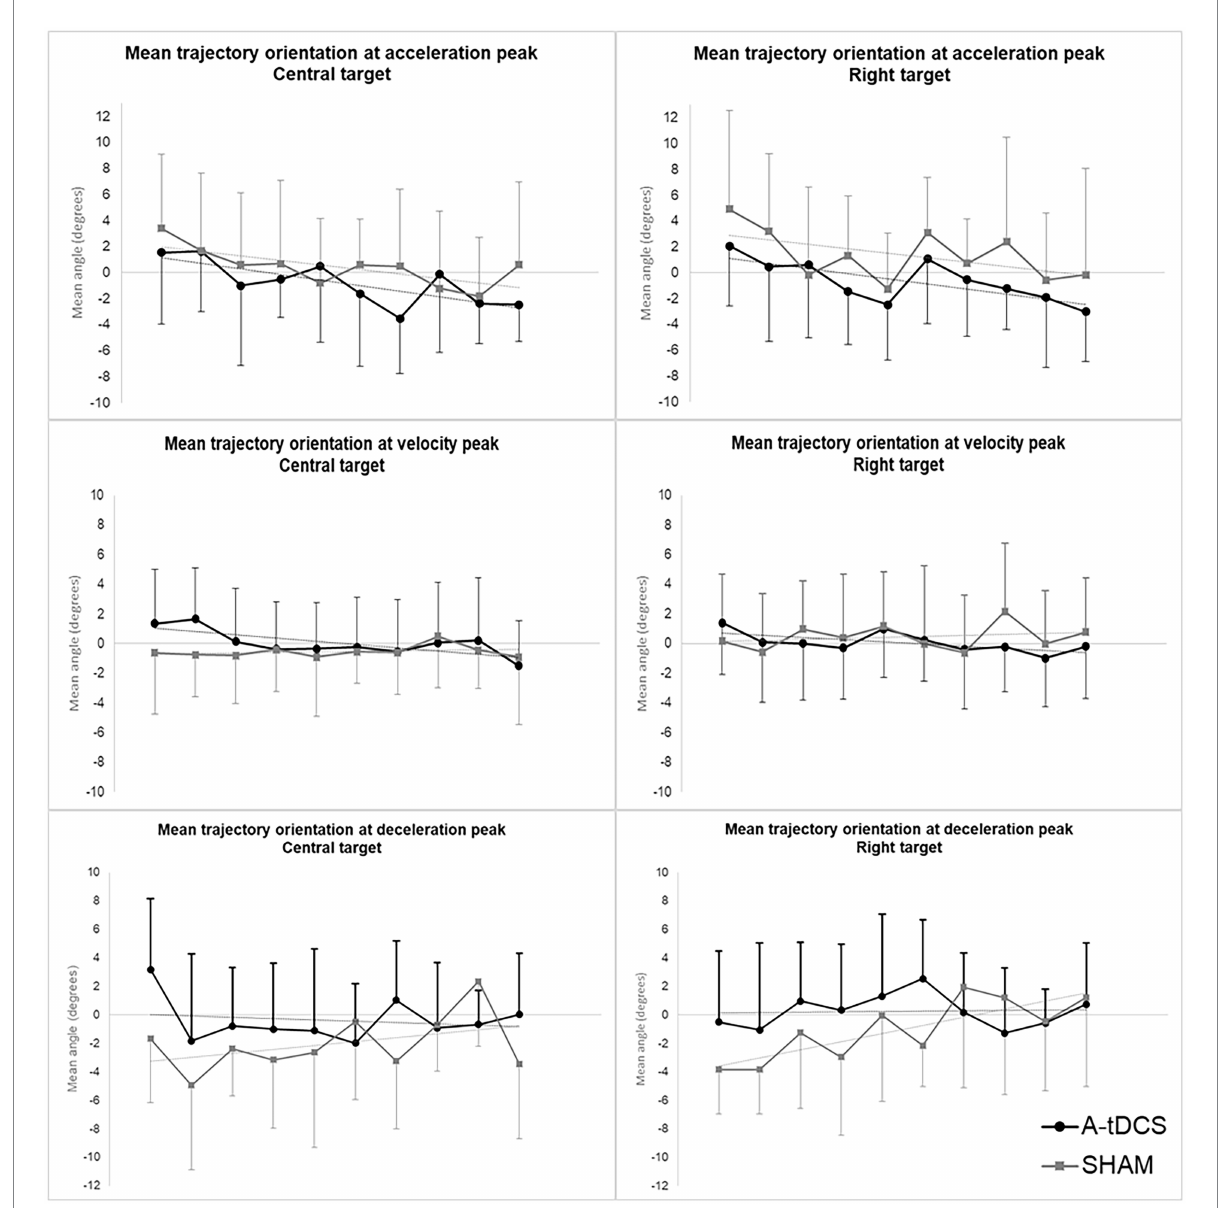
FIGURE 4 Mean group orientation of pointing trajectories at initial, intermediate, and terminal direction during post-tests. The figure depicts the evolution across trials of mean group orientations of velocity vectors at initial (acceleration peak), intermediate (velocity peak), and terminal (deceleration peak) direction of pointing movements during post-tests for the central target (left) and the right target (right). The A-tDCS group mean values are represented in black; Sham group values are represented in grey. Values are baseline subtracted and plotted with standard deviations. Negative value mean orientation to the left while positive values mean orientation to the